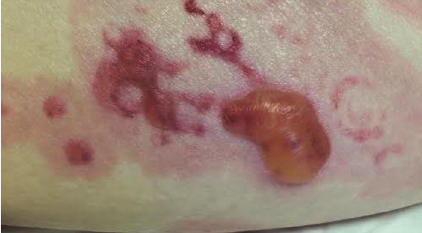
Figure 2: Tense bulla with perilesional vesicles on right thigh.